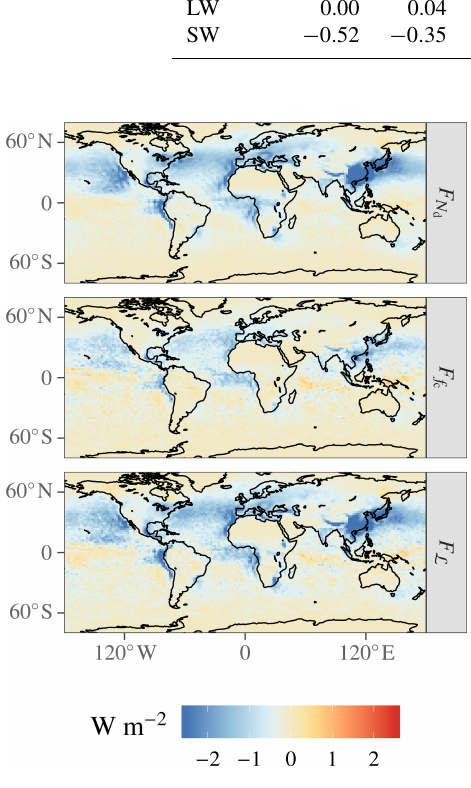
Figure 1. ERF aci components in ECHAM–HAMMOZ estimated by forward–backward